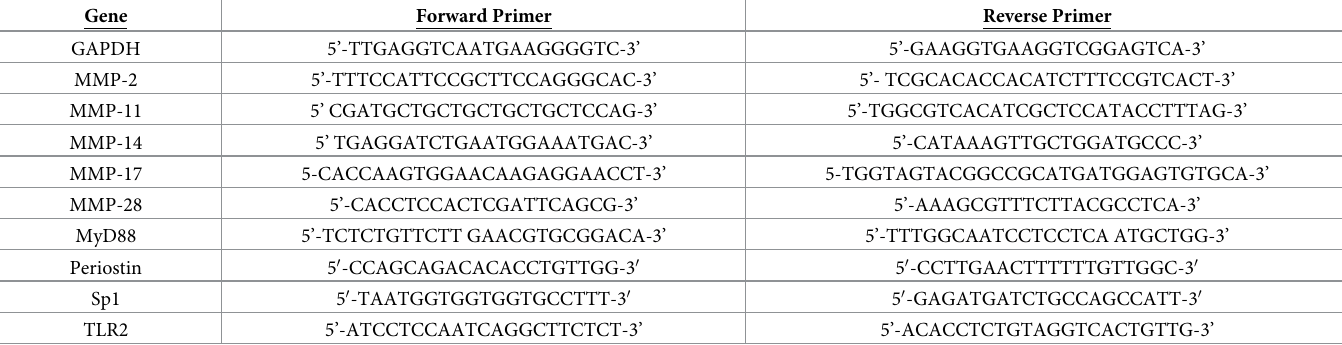
Table 1. RT-qPCR forward and revers primer pairs.